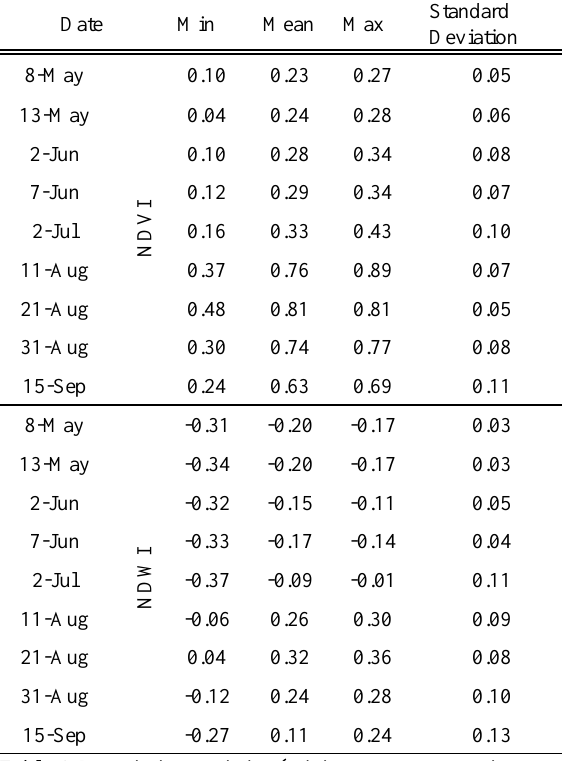
Table 2 Descriptive statistics (minimum, mean, maximum and standard deviation) of NDWI and NDVI captured at the 133 polygons of current wheat cropping area from cadastre data in the studied field, for each date, between May and September 2019.